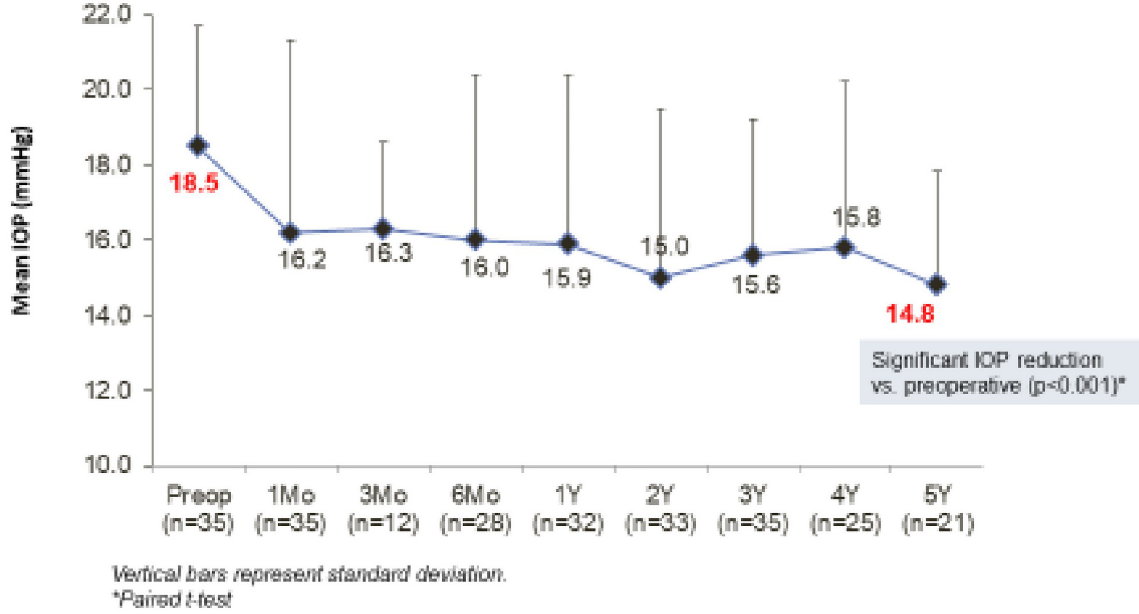
Fig 1. Mean IOP through 5 years post-operative. All eyes at each time